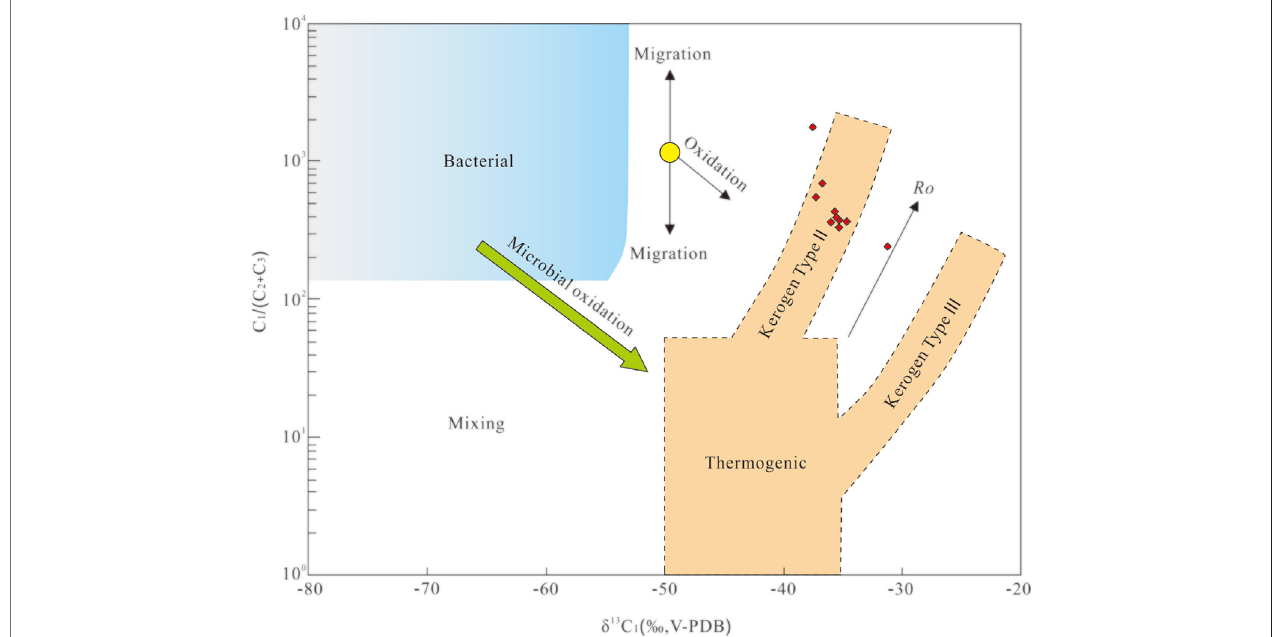
FIGURE 3 | Geochemical classi fi cation showing the genesis of shale gas in the study area (after Whiticar, 1999).